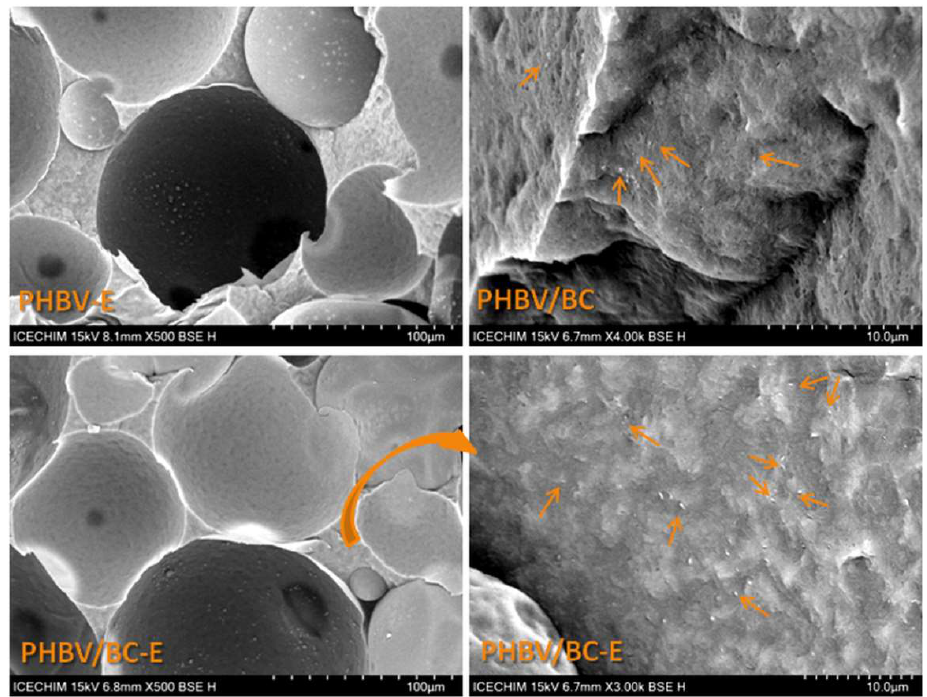
Figure 2. SEM images of PHBV-E, PHBV/BC, and PHBV/BC-E; the BC nanofibers are marked with arrows.